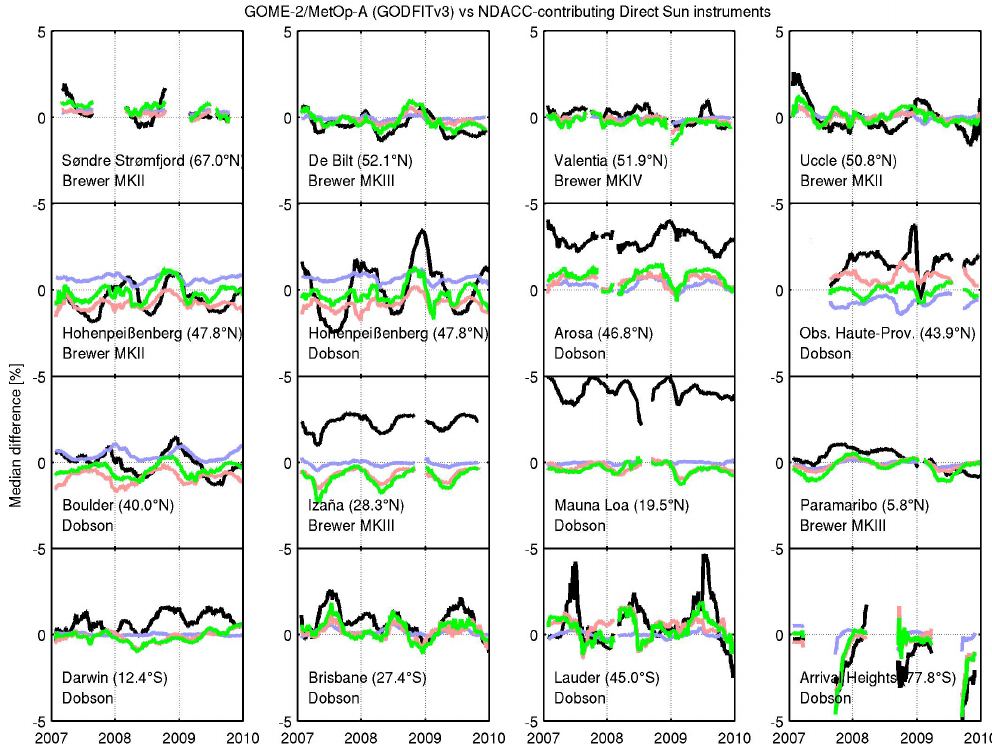
Figure 15. Similar to Fig. 14 but now for the median of the differences. The large median differences for Arosa, Mauna Loa, and Izaña are due to the high-altitude location of these stations, for which no correction was implemented